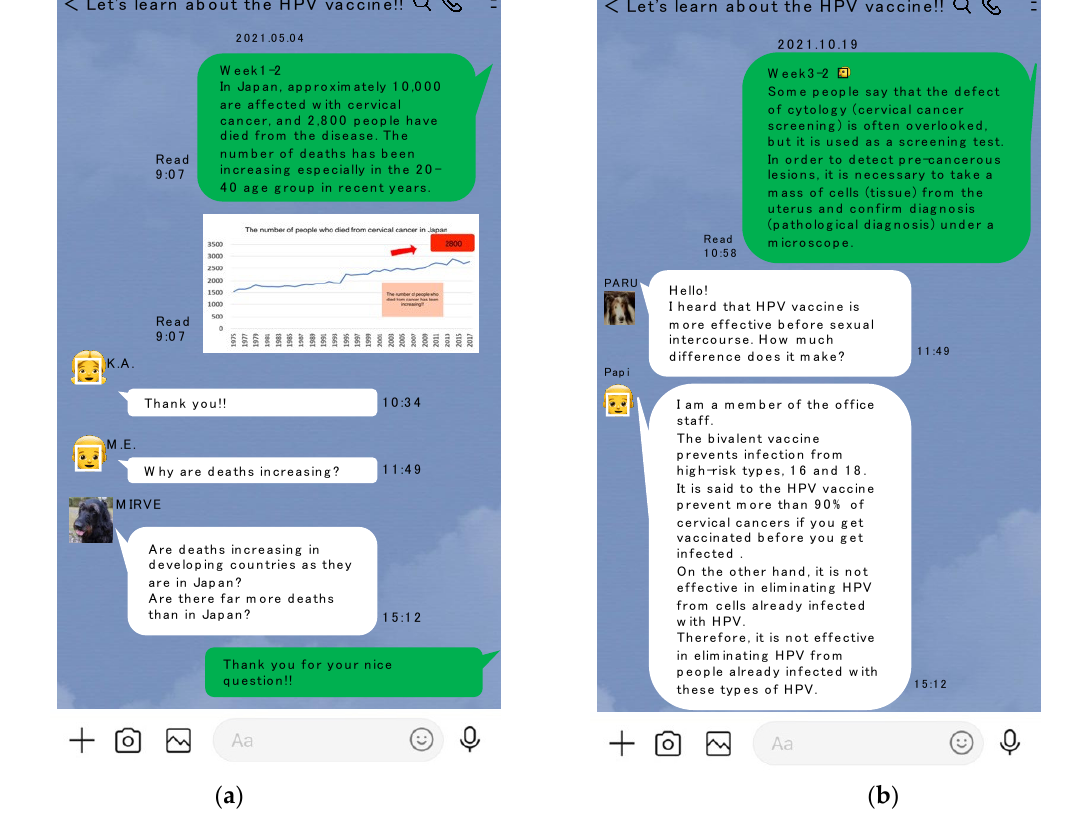
Figure 2. The image of the second intervention (reproduced for this article): ( a ) Round 1, ( b ) Round 2.